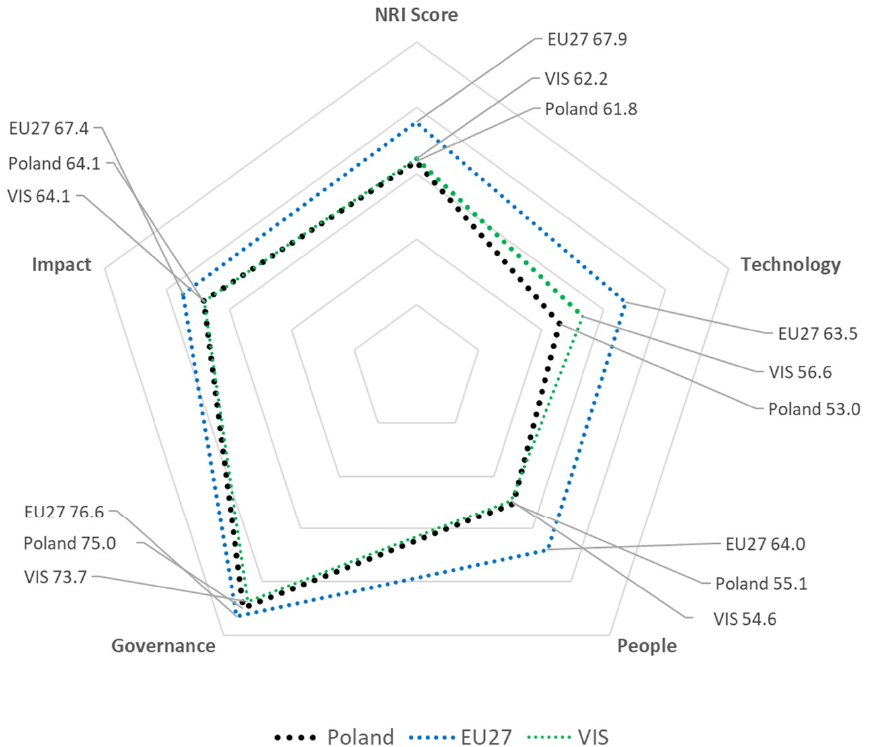
Figure 9. Technology knowledge of citizens represented by scores for the Network Readiness Index (NRI) on the national application and impact of ICT. Source: WEF 2020 [46].